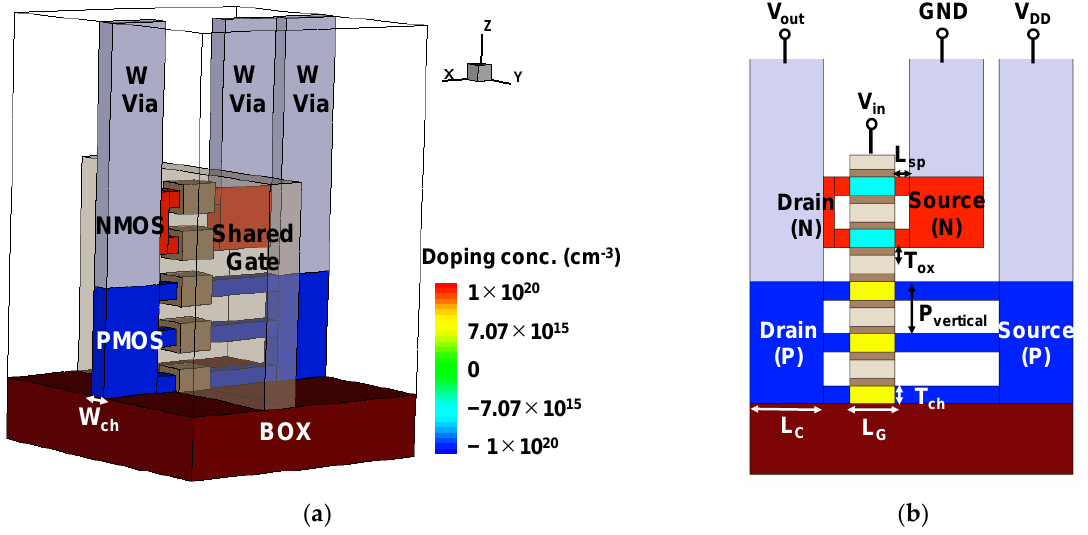
Figure 1. ( a ) The 3-D device structure of CFET and ( b ) the CFET’s cross -sectional view on the y -axis cutting plane sitting in the middle of the channel.